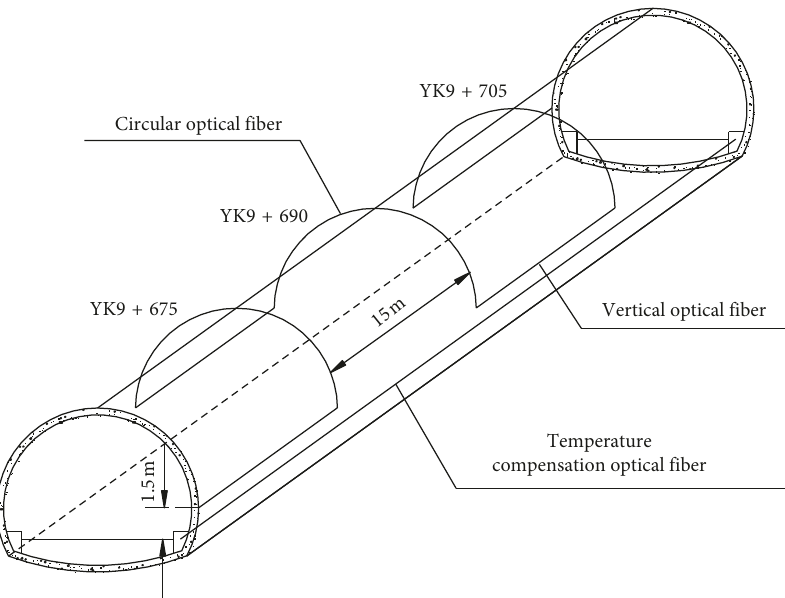
Figure 11: Arrangement of the distributed optical